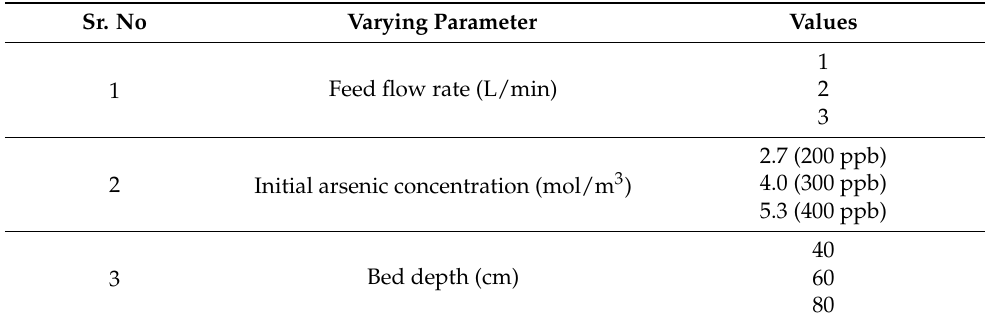
Table 2. Simulation parameters. Sr.